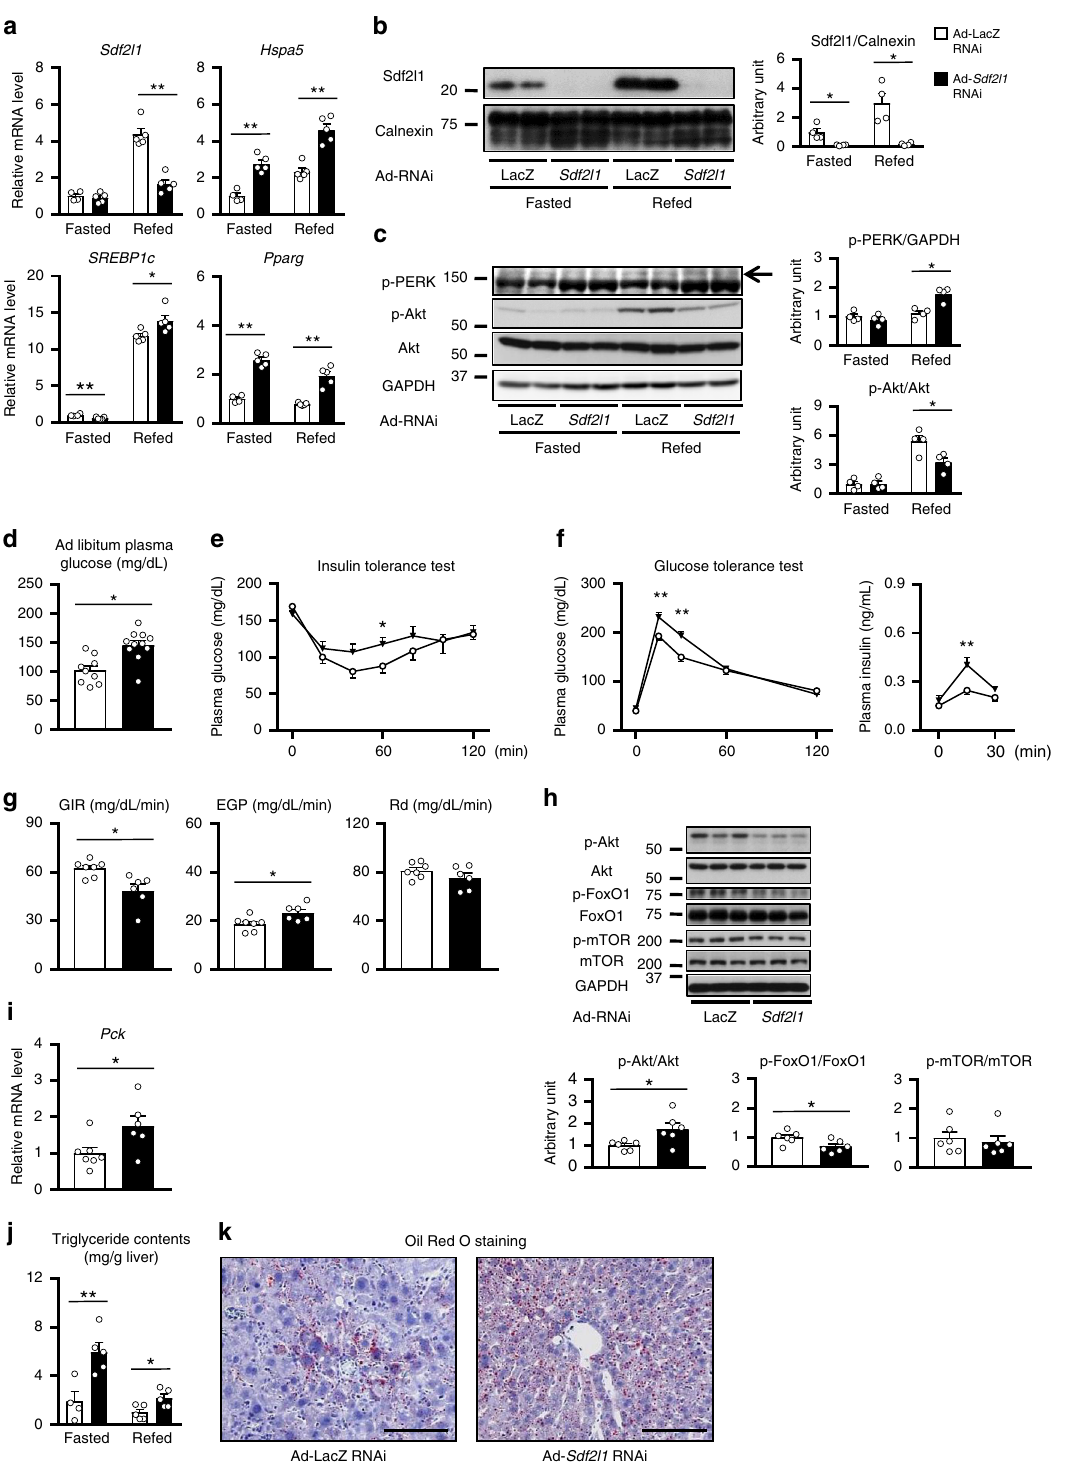
Fig. 3 Functions of Sdf2l1 in vivo. Wild-type mice were administered with Ad- Sdf2l1 RNAi intravenously (2.0 × 10 7 PFU/g BW) to knock down the gene in the liver. a – c ER stress and insulin signaling in the liver ( n = 4 – 5), analyzed by a RT-PCR ( n = 4 – 5), b Western blotting of microsomal fractions ( n = 4), and c Western blotting of total lysates ( n = 4). d – f Effects of knocking down on glucose metabolism ( n = 9 – 11): d ad libitum-fed plasma glucose, e plasma glucose in insulin tolerance test (ITT), after intraperitoneal injection of human regular insulin (0.75 U/kg BW), f plasma glucose and insulin levels in an oral glucose tolerance test (OGTT), after oral administration of glucose (0.75 g/kg BW), following 16h of fasting. g – i Results of hyperinsulinemic-euglycemic clamp studies after 3 h of fasting (2.5 mU/kg/min, n = 6 – 7), in wild-type mice with Sdf2l1 knocked down: g glucose infusion rate (GIR), endogenous glucose production (EGP), and rate of glucose disappearance (Rd); h , i the liver samples after the clamp studies were analyzed by h Western blotting and i RT-PCR. j , k Effects of knocking down on lipid metabolism, analyzed with j triglyceride contents quanti fi cation ( n = 4 – 5), and k Oil Red O staining. Values of the data are expressed as mean± SEM. * P < 0.05, ** P < 0.01. Unpaired 2-tailed t -test was used for assessment. Scale bars: 100 μ